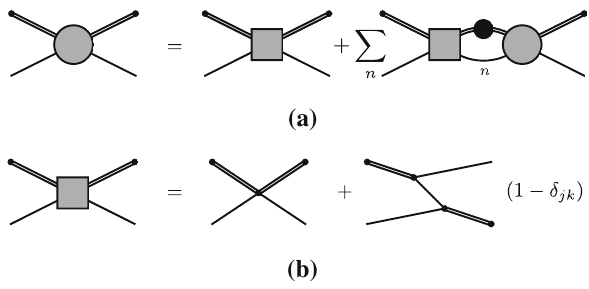
Fig. 8 a Diagrammatic representation of the B -matrix parameteriza- tion in Eq. (23). The gray disk represent the amputated PWIS, and the gray box the B -matrix. b The B -matrix is composed of a short-range real R amplitude, and the OPE E , see Eq.